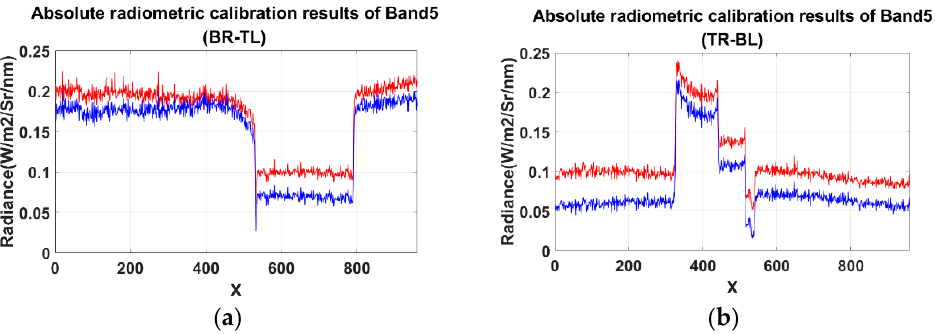
Figure 24. Diagonal radiance value of the spectral images calibrated by the LUT method (blue) and manufacturer’s method (red): ( a ) radiance value of BR-TL diagonal in five bands; ( b ) radiance value of TR-BL diagonal in five